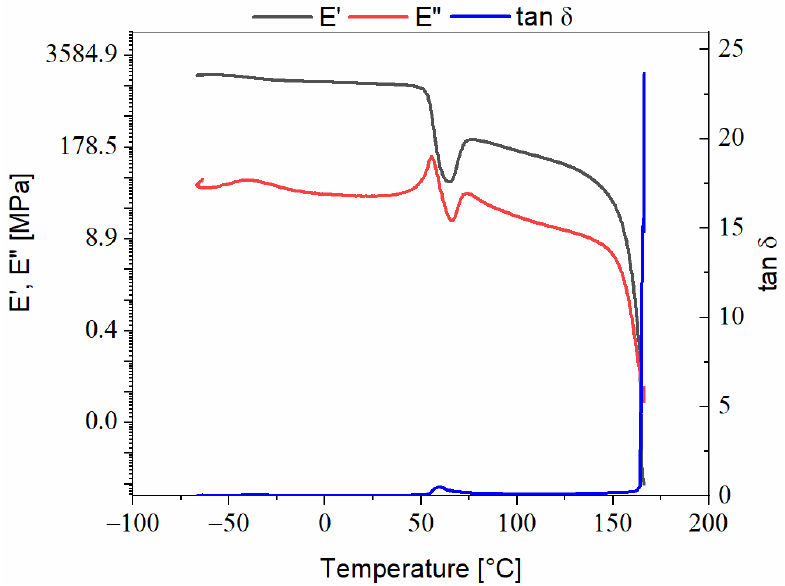
Figure 2. DMA thermogram recorded during heating of Arboblend ® V2 Nature. Arbofill ® Fichte, Figure 3: